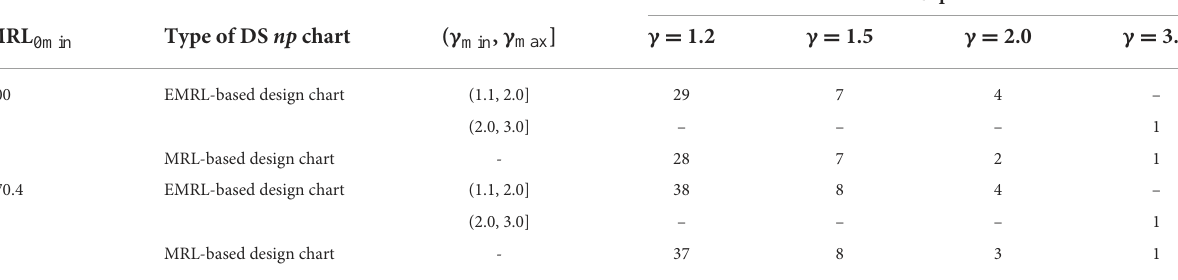
TABLE 6 MRL 1 computed using the optimal charting parameters of the EMRL-based DS np chart and the MRL-based DS np chart for p 0 = 0.02, n = 100, and EMRL 0 ∈{ 200, 370.4 }